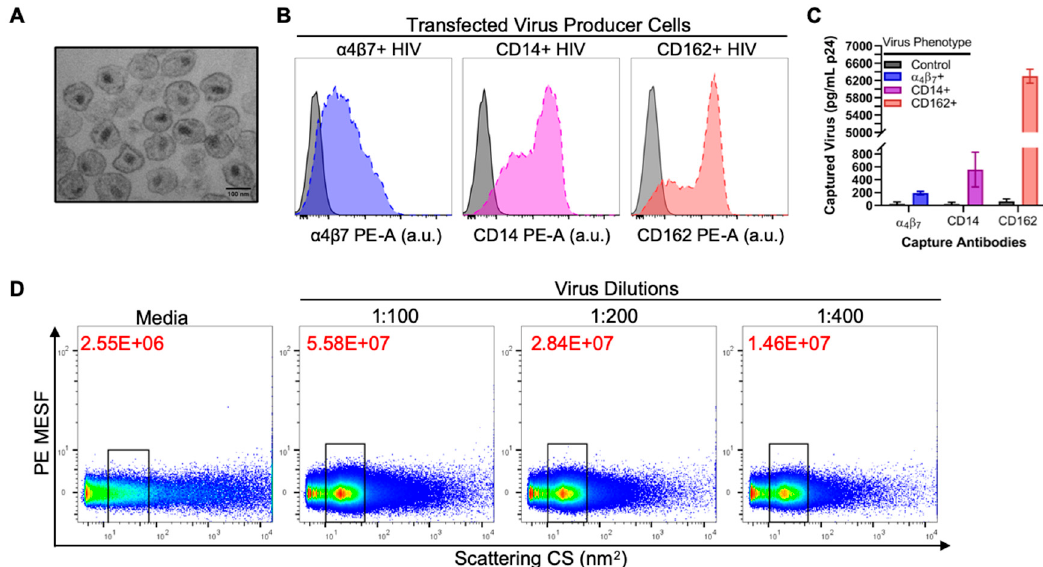
Figure 1. Validation and quality control of viral stocks to be used in flow virometry. ( A ) HIV-1 pseudoviruses (SG3 ∆ env ) used in this study as visualized by transmission electron microscopy. Image shown represents free virions from one section of virus-producing HEK293 cells and was reproducible across 5 di ff erent cell sections that were imaged. ( B ) Cell surface expression of transfected host proteins ( α 4 β 7, CD14, or CD162) as analyzed by flow cytometry. Colored dotted line histograms indicate positive staining when the respective host protein was co-transfected ( α 4 β 7 + , CD14 + , or CD162 + ) with SG3 ∆ env , while control (grey solid line) histograms indicate negative staining with the anti-host protein antibodies on cells producing control virus (SG3 ∆ env alone), without co-transfection of host protein. ( C ) Detection of virion-incorporated host proteins by antibody capture assay, with each virus type indicated by a di ff erent bar color (“virus phenotype” containing di ff erent host proteins). Control virus contains no host protein, only the SG3 ∆ env backbone. Captured virus is presented as the amount of p24 (pg / mL) after lysis of bead-associated virus. Data shown indicate the mean level of virus capture +/ − SD for duplicate samples after removal of the background noise (non-specific IgG capture). ( D ) Serially diluted (1:100, 1:200, 1:400) preparations of unstained control HIV are shown with gating on the pseudovirus population. Particle concentrations (particles / mL) were calculated based on events in the gated regions when acquired at a sample rate of 10 µ L / min for 1 min, denoted in red on each dot plot. Media alone is shown to indicate the level of instrument noise and background noise present.